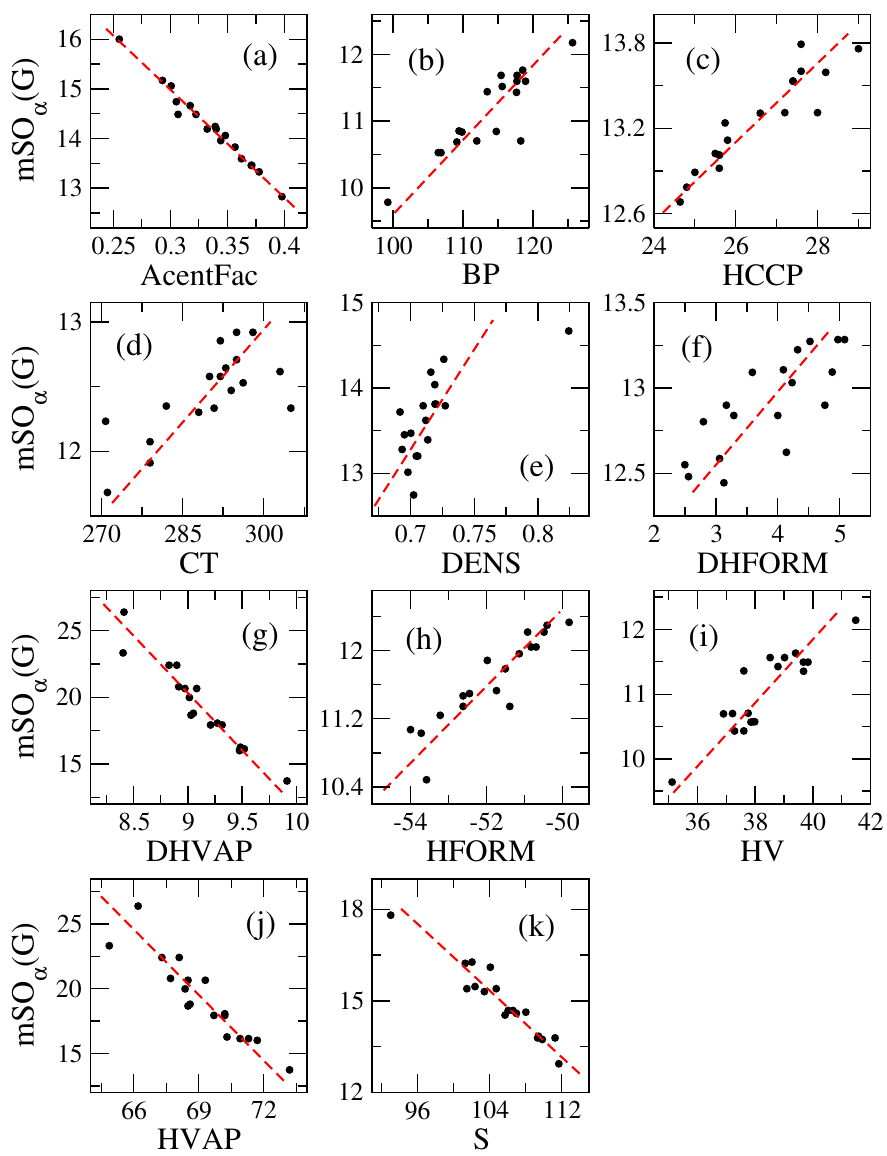
Figure 1: Mean Sombor index mSO vs. the physicochemical properties of octane isomers, for the values of α that α ( G ) maximize the correlations: (a) α = 0 , (b) α = − 8 . 19 , (c) α = − 0 . 87 , (d) α = − 2 . 05 , (e) α = − 0 . 53 , (f) α = − 1 . 28 , (g) α → ∞ , (h) α = − 4 . 23 , (i) α → −∞ , (j) α → ∞ , and (k) α = 0 . 58 . Red dashed lines are the linear QSPR models of Equation (5),